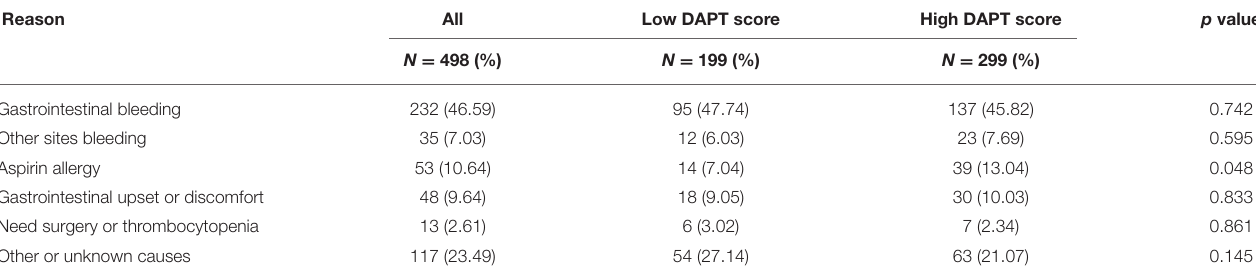
TABLE 1 | Reasons for premature discontinuation of